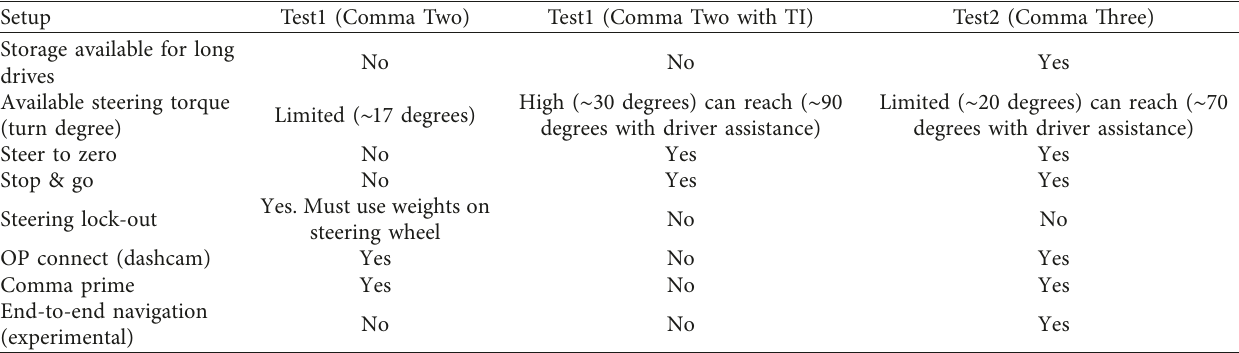
Table 9: Comparison of OP features in different hardware.